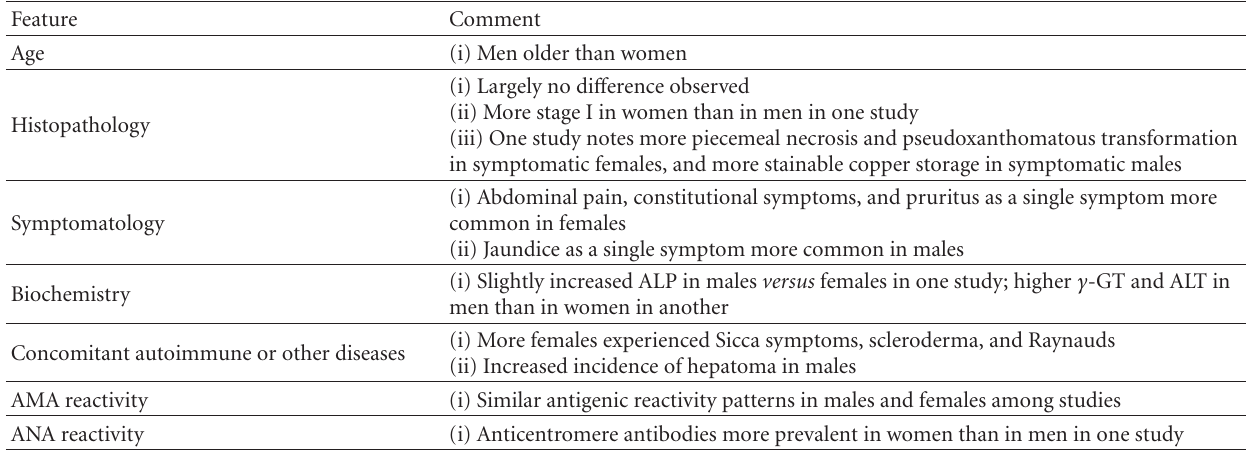
Table 1: Features of primary biliary cirrhosis (PBC) in men and women. Although PBC in men and women is largely similar, certain clinical features such as symptomatology and concomitant diseases di ff er between the sexes. Very little di ff erence is noted in regards to histological or biochemical features, as well as antimitochondrial antibody (AMA)